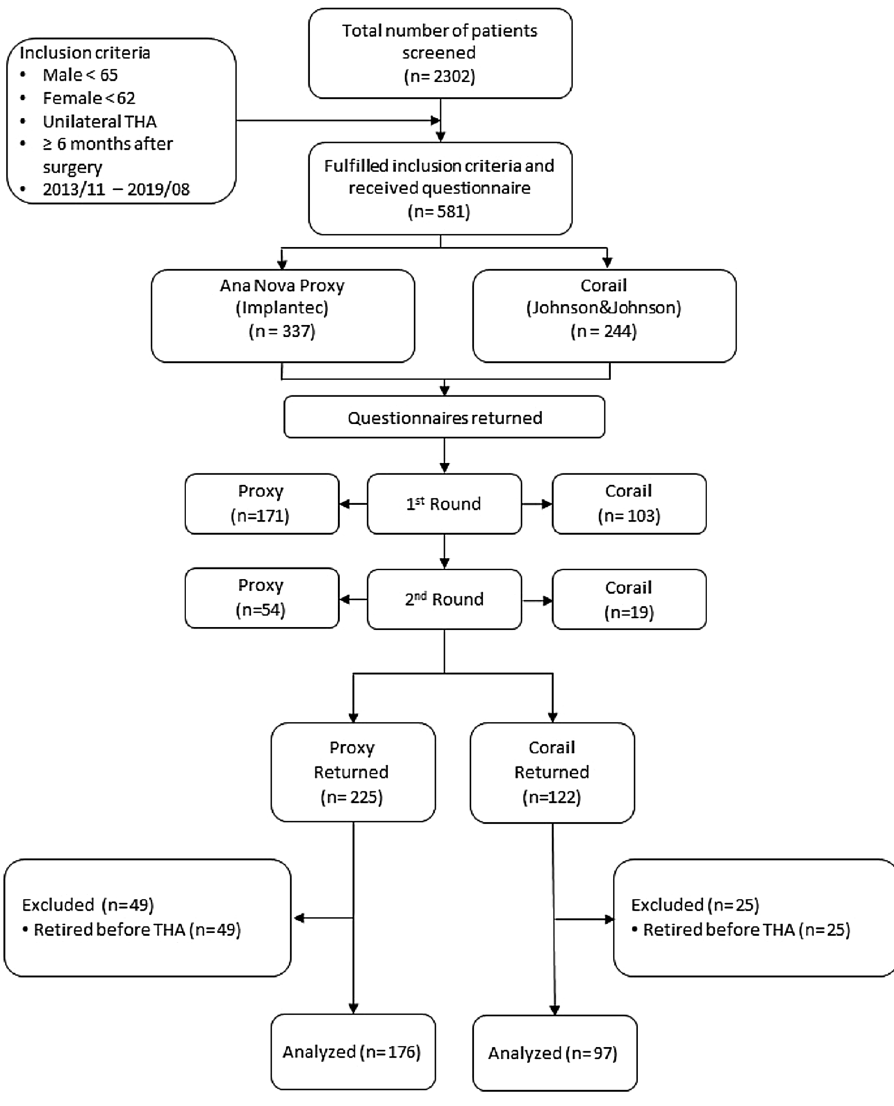
Figure 1. Patient flow chart on study inclusion.